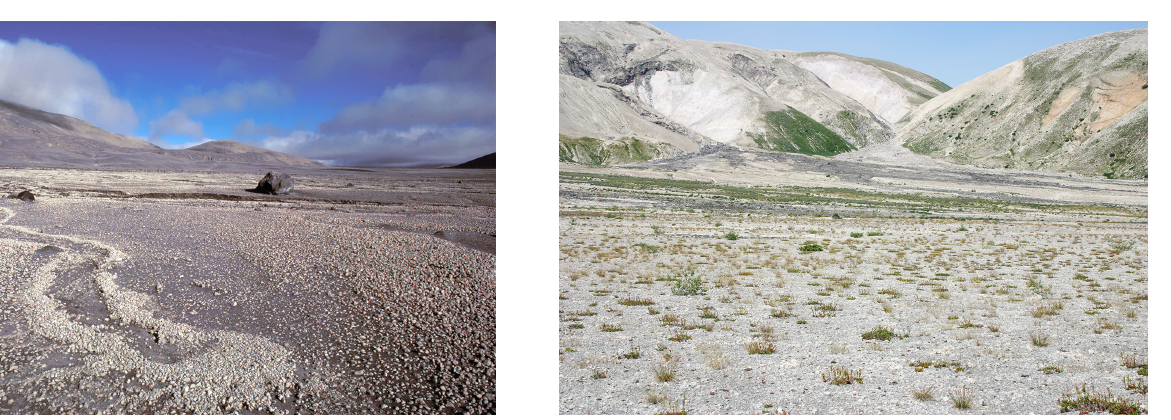
Fig. 10. Plains of Abraham showing total lack of vegetation (Photo: RdM September 1980).